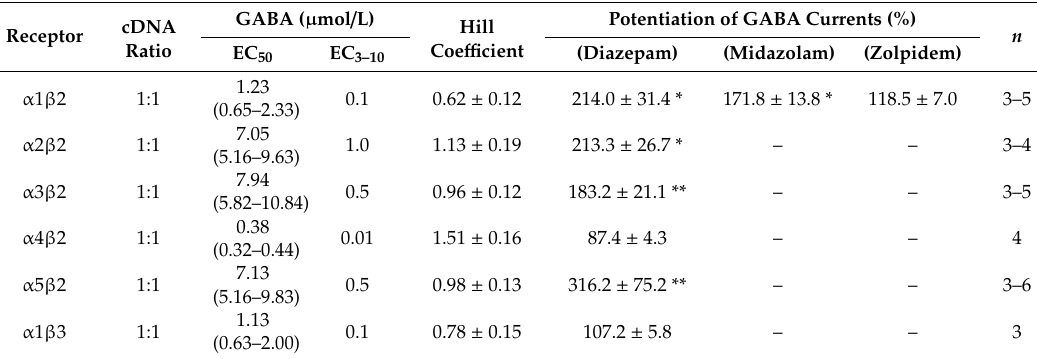
Primary parameters obtained from Figure 1 ‐ 3. Values are mean ± SEM; * P < 0.05, ** P < 0.01 vs. control group.